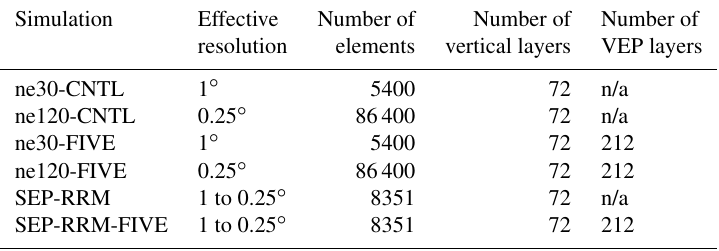
Table 1. Description of the simulations performed.